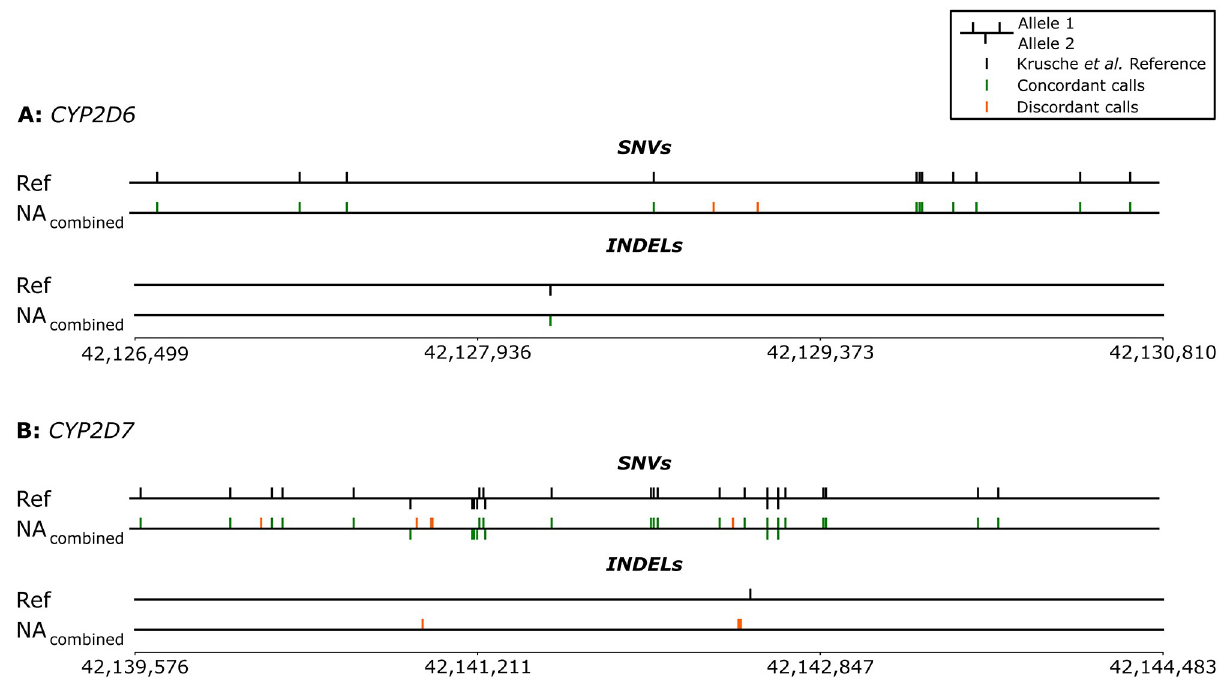
Fig 3. Representation of the called and phased small variants (SNVs and INDELs) in the CYP2D6 and CYP2D7 genes of the NA combined library. The truth set composed by Krusche et al. [36] was used as reference (Ref). Green lines represent concordant calls (true-positives compared to the truth set), which are correctly called and phased variants compared to the reference; orange lines represent discordant calls (false-positives compared to the truth set). Note: multiple variants next to each other are visually represented by thicker